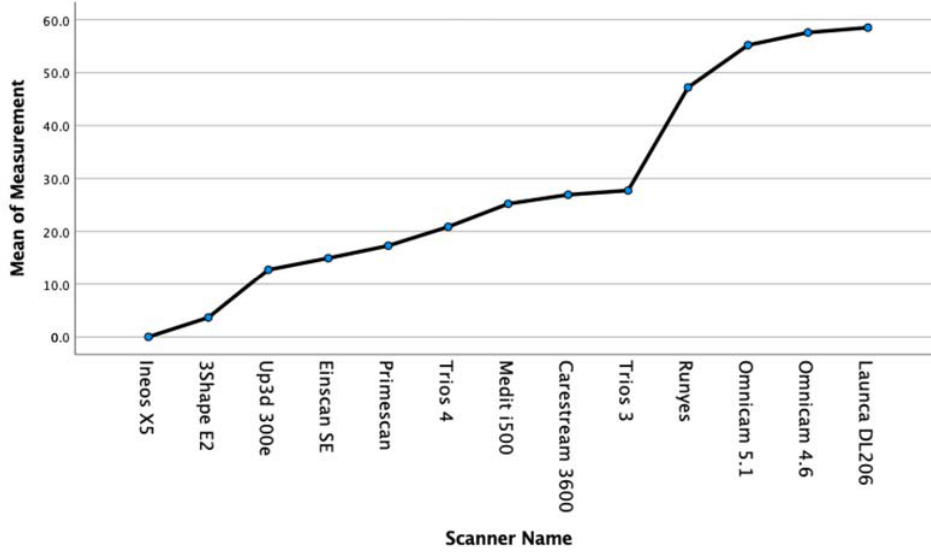
Figure 3. Box plot of each data set for each scanner in the present study. * represents outlier. Table 3. Tukey homogenous subsets of compared means (subset for alpha = 0.05).